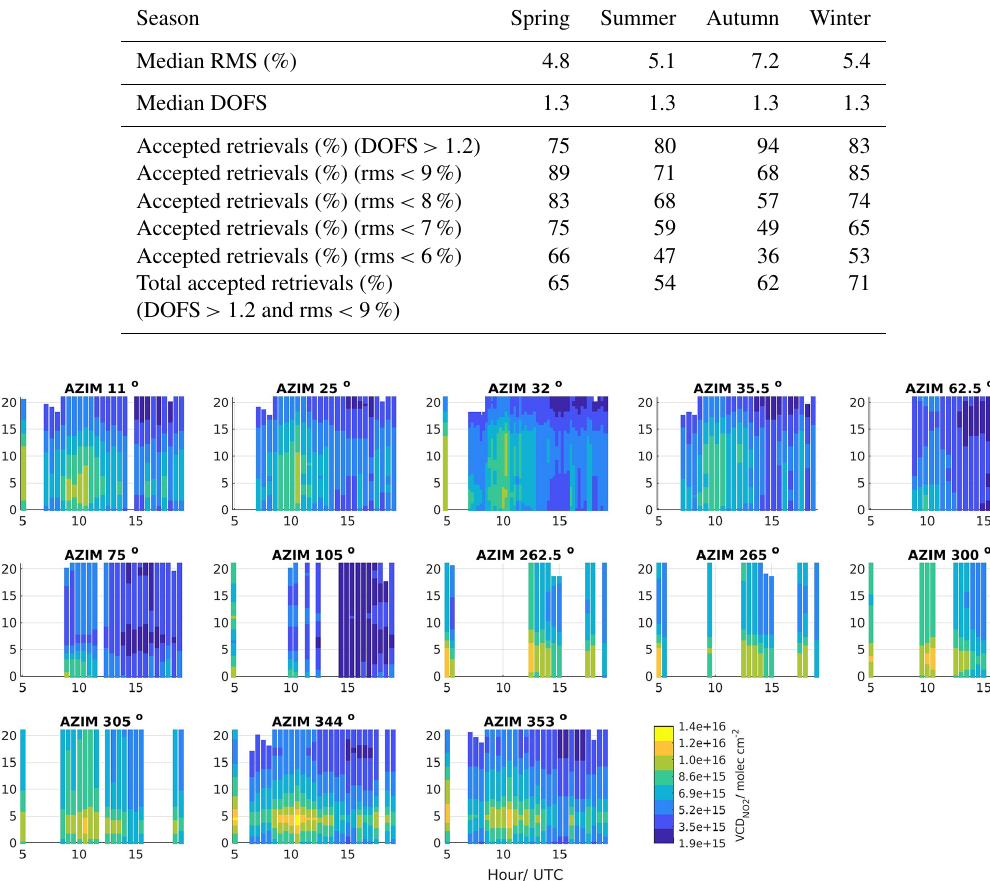
Figure 17. Diurnal variation of the retrieved NO 2 horizontal profiles per azimuthal direction as a function of time (UTC) for 28 June 2019.